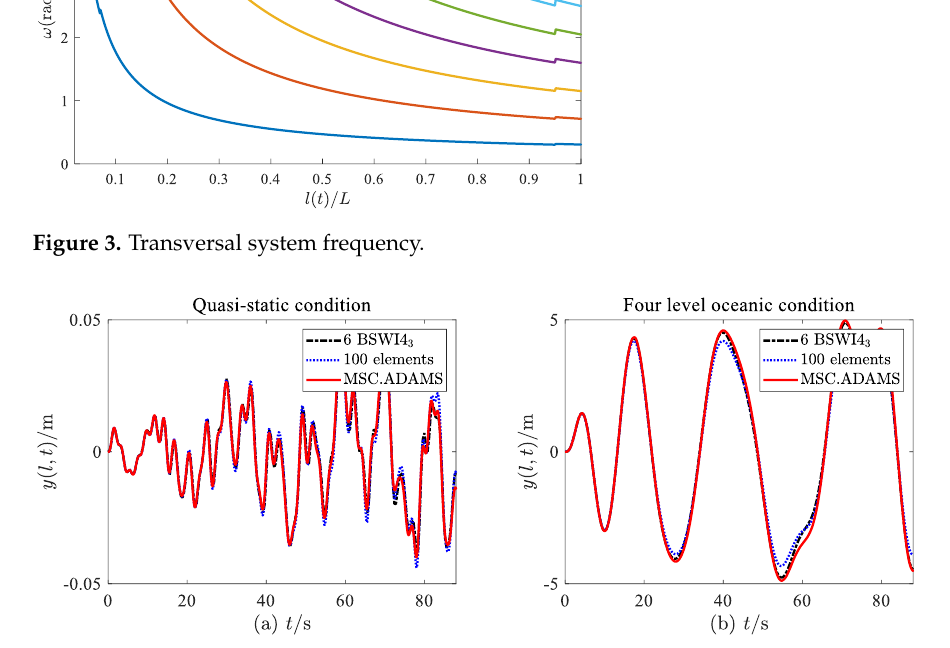
Figure 4. Transverse displacement of the tethered deep-sea robot with boundary disturbance: dashdot black, dotted blue and solid lines represented by 6 BSWI43 elements, 100 elements and MSC.ADAMS, respectively. ( a ) quasi-static condition; ( b ) four-level oceanic